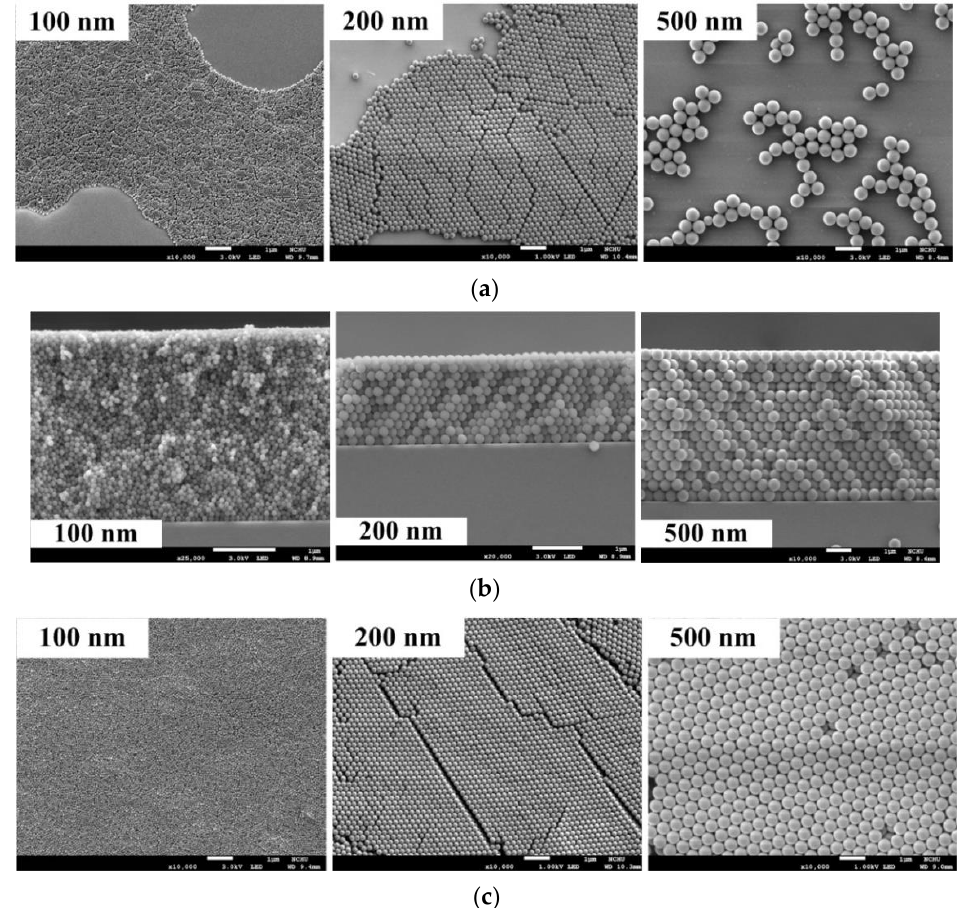
Figure 2. SEM images of PS NS array with diameters of 100, 200 and 500 nm under ( a ) the high spin speed, ( b ) the low spin speed, and ( c ) high volume of the droplet of PS NS colloidal suspension from the pipette (13 μL/drop).